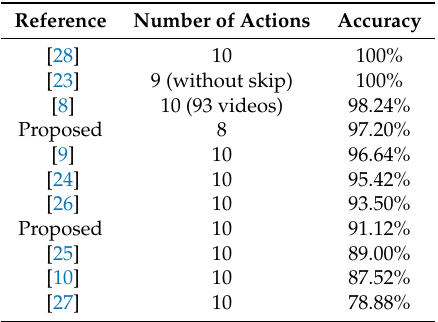
Table 3. Comparison of recognition rates obtained on the Weizmann database (cited methods are explained in Section 2. Related